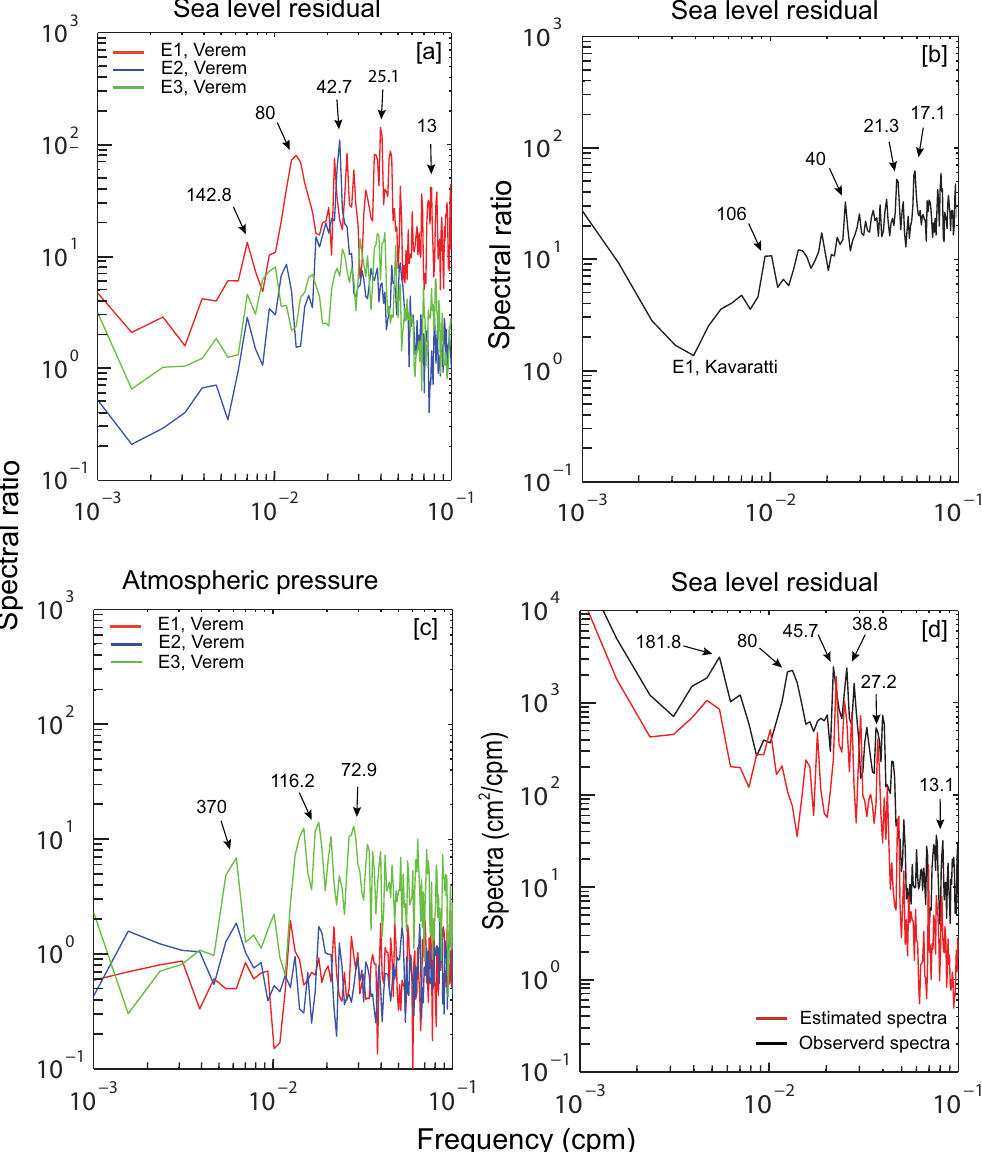
Fig. 8. Spectral ratio (i.e., ratio of spectra during the event to that of the respective background oscillations) of (a) SLR at Verem (Goa) during the events E1, E2 and E3, (b) SLR at Kavarrati during event E1, (c) atmospheric pressure anomaly at Verem (Goa) during the events E1, E2 and E3. (d) Observed (black) and the computed (red) spectra of SLR at Verem for event E1. The computed SLR spectrum is obtained using atmospheric pressure during E3 based on Eq. (9). The numbers associated with significant peaks are time period in